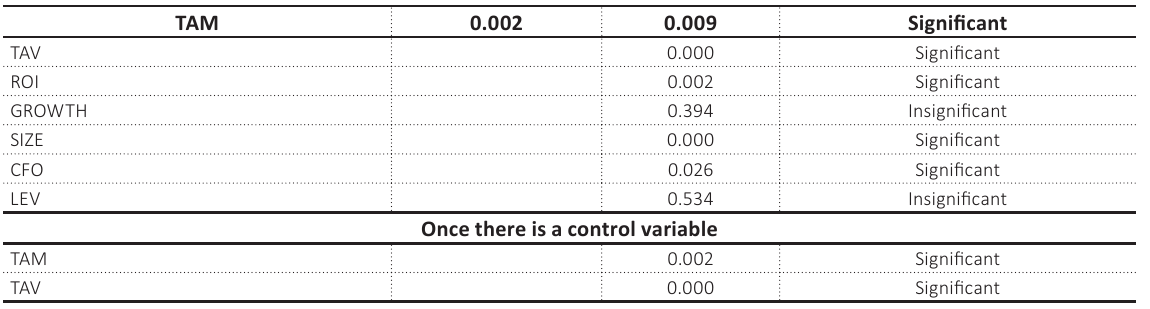
Table 3. Partial correlation analysis